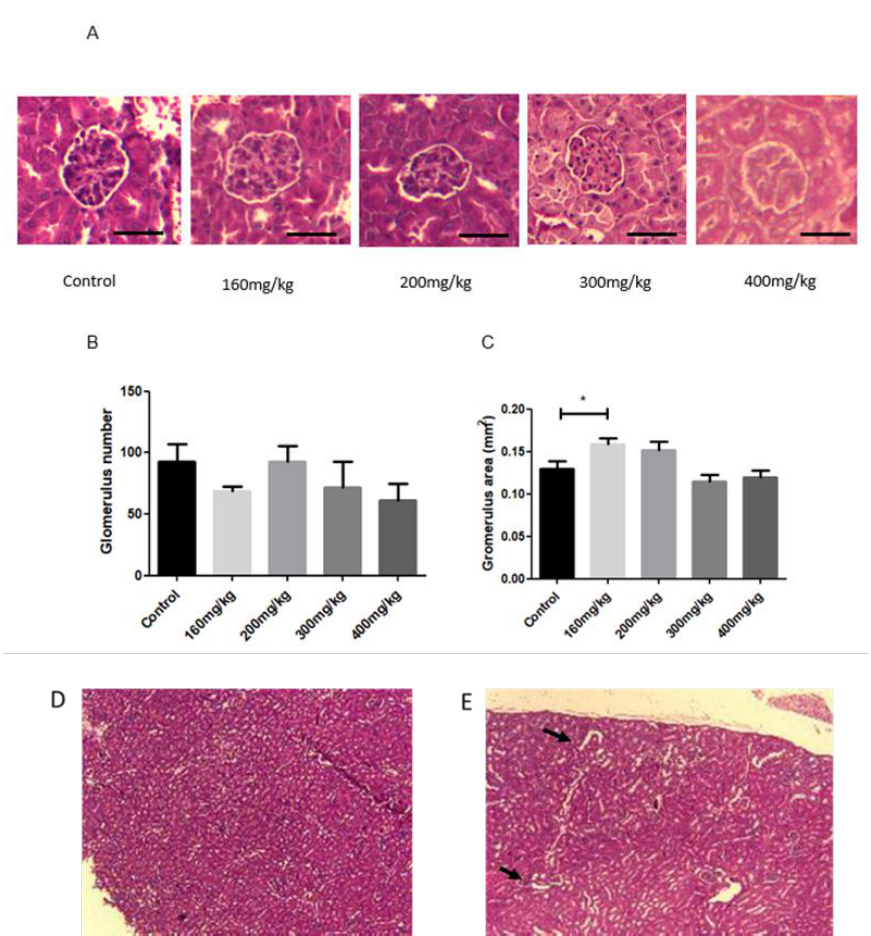
Figure 9. Glomerulus morphology in kidneys of STZ-induced diabetic mice treated with STZ at different concentrations (160 – 400 mg/kg). Representative hematoxylin and eosin staining of the glomerulus of kidneys was examined by light microscopy (magnification 10×) ( A ). The quantifica- tions of glomerulus number and glomerulus area were determined by ImageJ software ( n = 2; n = 3; n = 4; n = 3, shown in mm 2 ) ( B , C ). The tubular dilation appeared in STZ-treated mice ( E , arrows) but not in control mice ( D ). Data are presented as mean SEM. STZ, streptozotocin; control non- treated mice. Statistically significant values are marked with (*); p < 0.05; Scale bar: 20 µm.